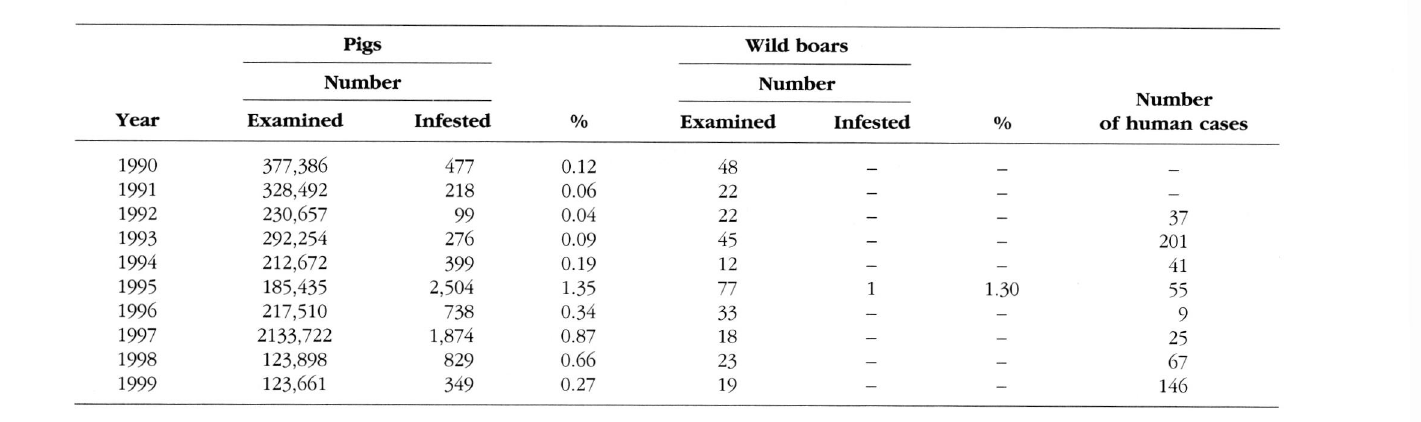
Table III. - Trichinellosis in humans, pigs and wild boars in Constantza County between 1990 and 1999 (Olteanu, 1996).